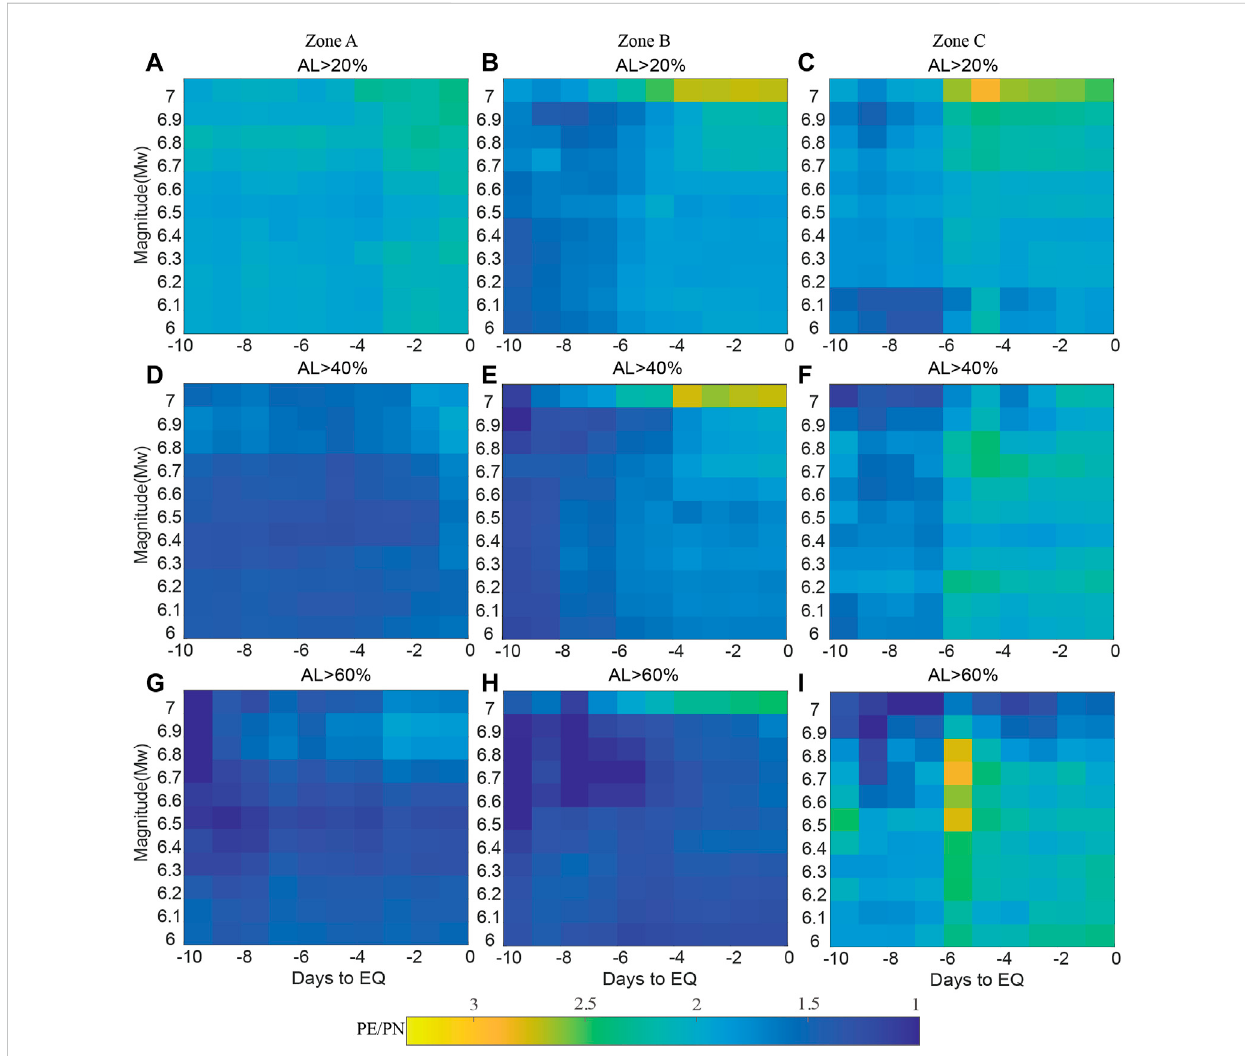
FIGURE 11 The ratio of the seimo-ionospheric anomalies occurrence rates within 1-10 days before the earthquakes to the ionospheric anomalies occurrence rates during backgrounddays (15-day sliding window). (A, D,G) represent the results inZone A. (B,E, H) represent theresults inZone B. (C, F,I) represent the results in Zone